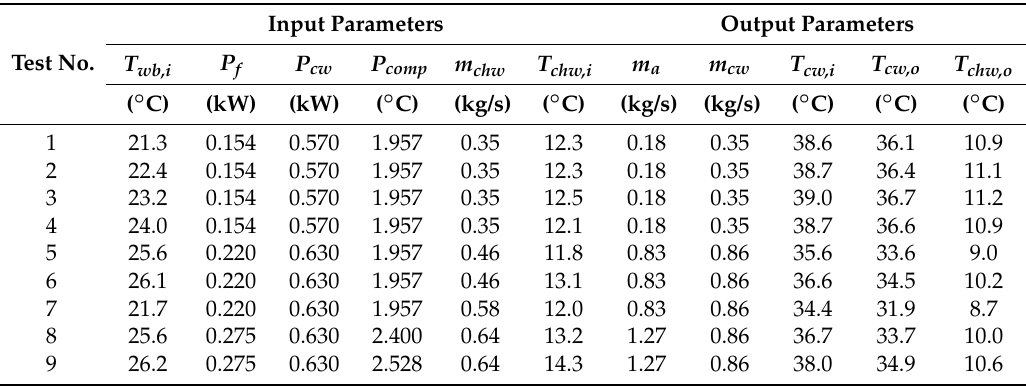
Table 2. The experimental data of the CTAHP tests.